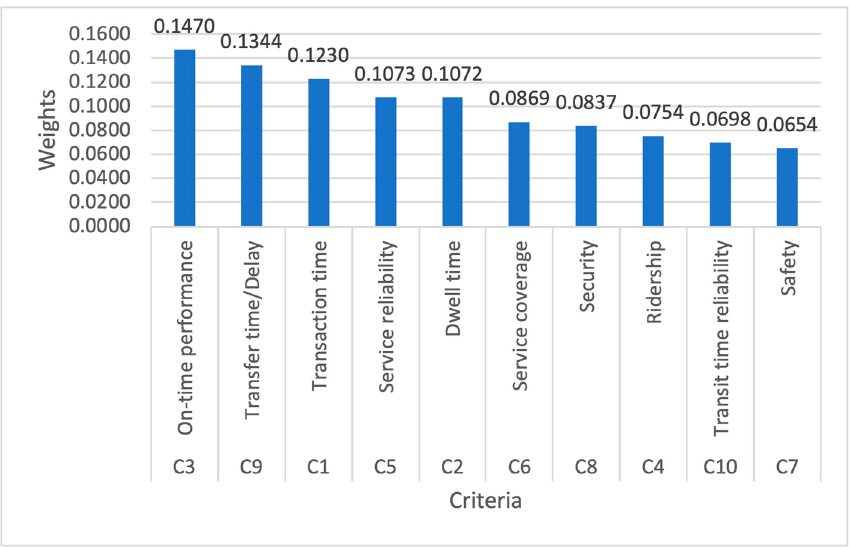
Figure 4. Ranks and weights of smart card system evaluation criteria.